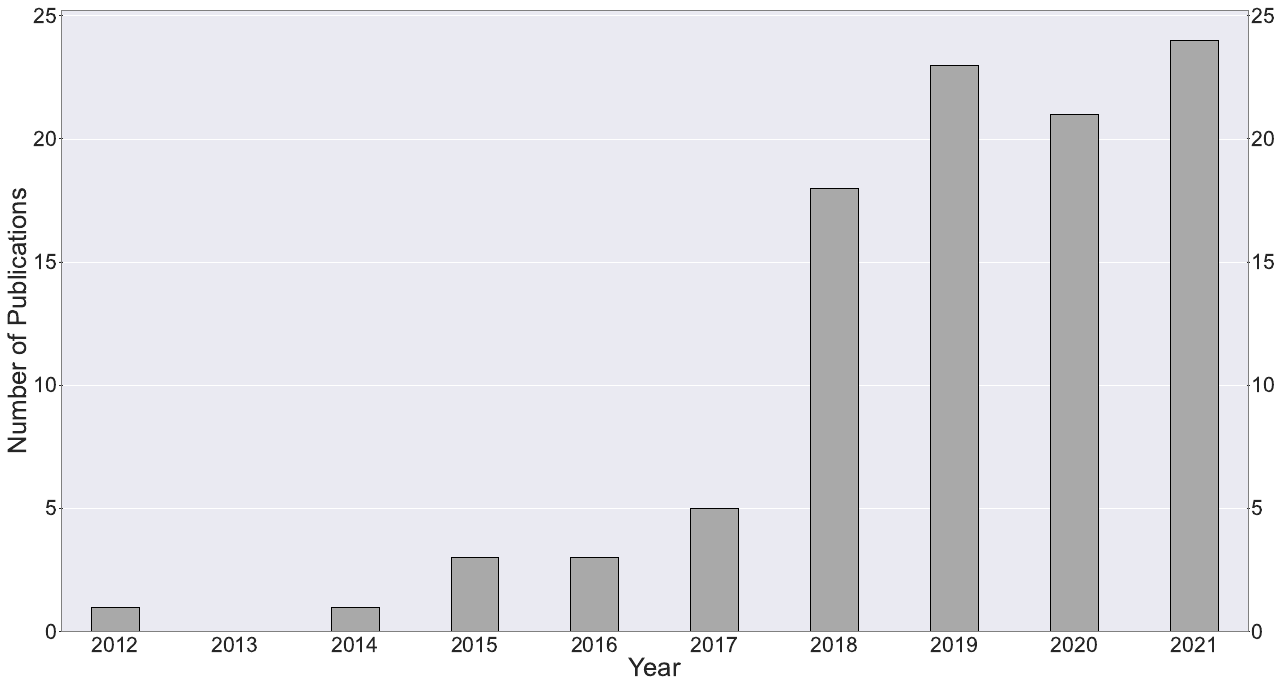
Figure 6. Bar graph of peer-reviewed papers related to UAV-based forest health monitoring published between 2012 and